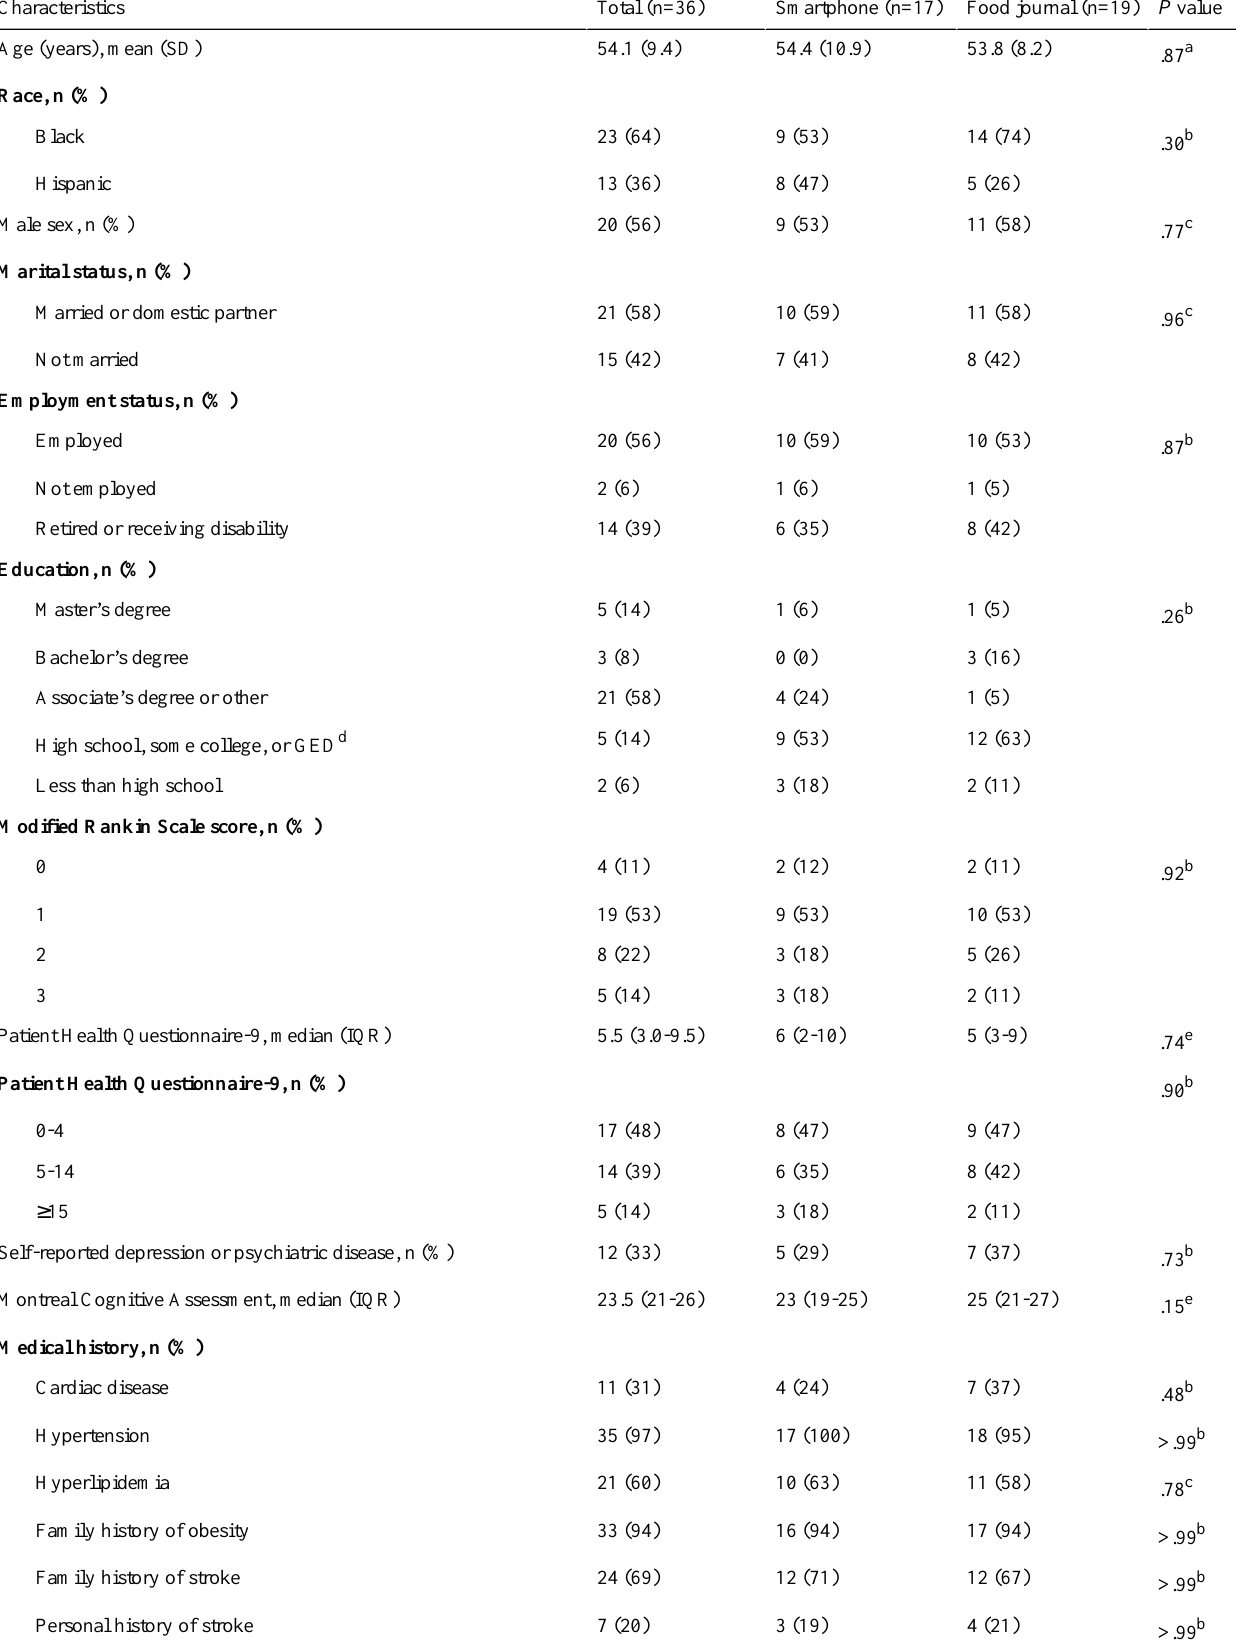
Table 1. Demographics and self-reported cerebrovascular risk